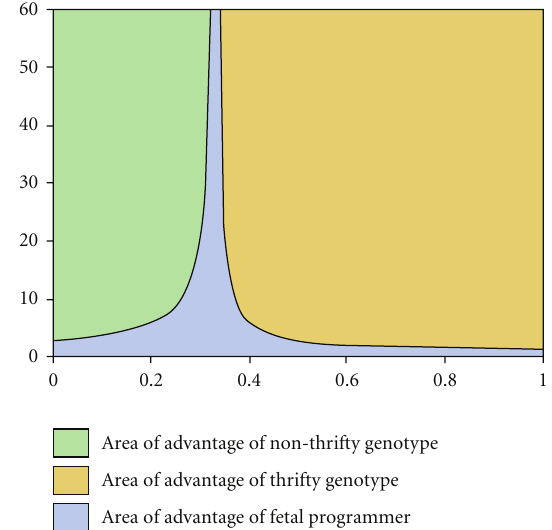
Figure 2: Parameter areas of advantage when nonthrifty genotype, thrifty genotype, and fetal programmer compete simultaneously. Fetal programming can evolve for species with short lifespan. If the life span is longer, fetal programming is unlikely to o ff er selective advantage over thrifty or nonthrifty genotypes except for a specific and very narrow range of pf